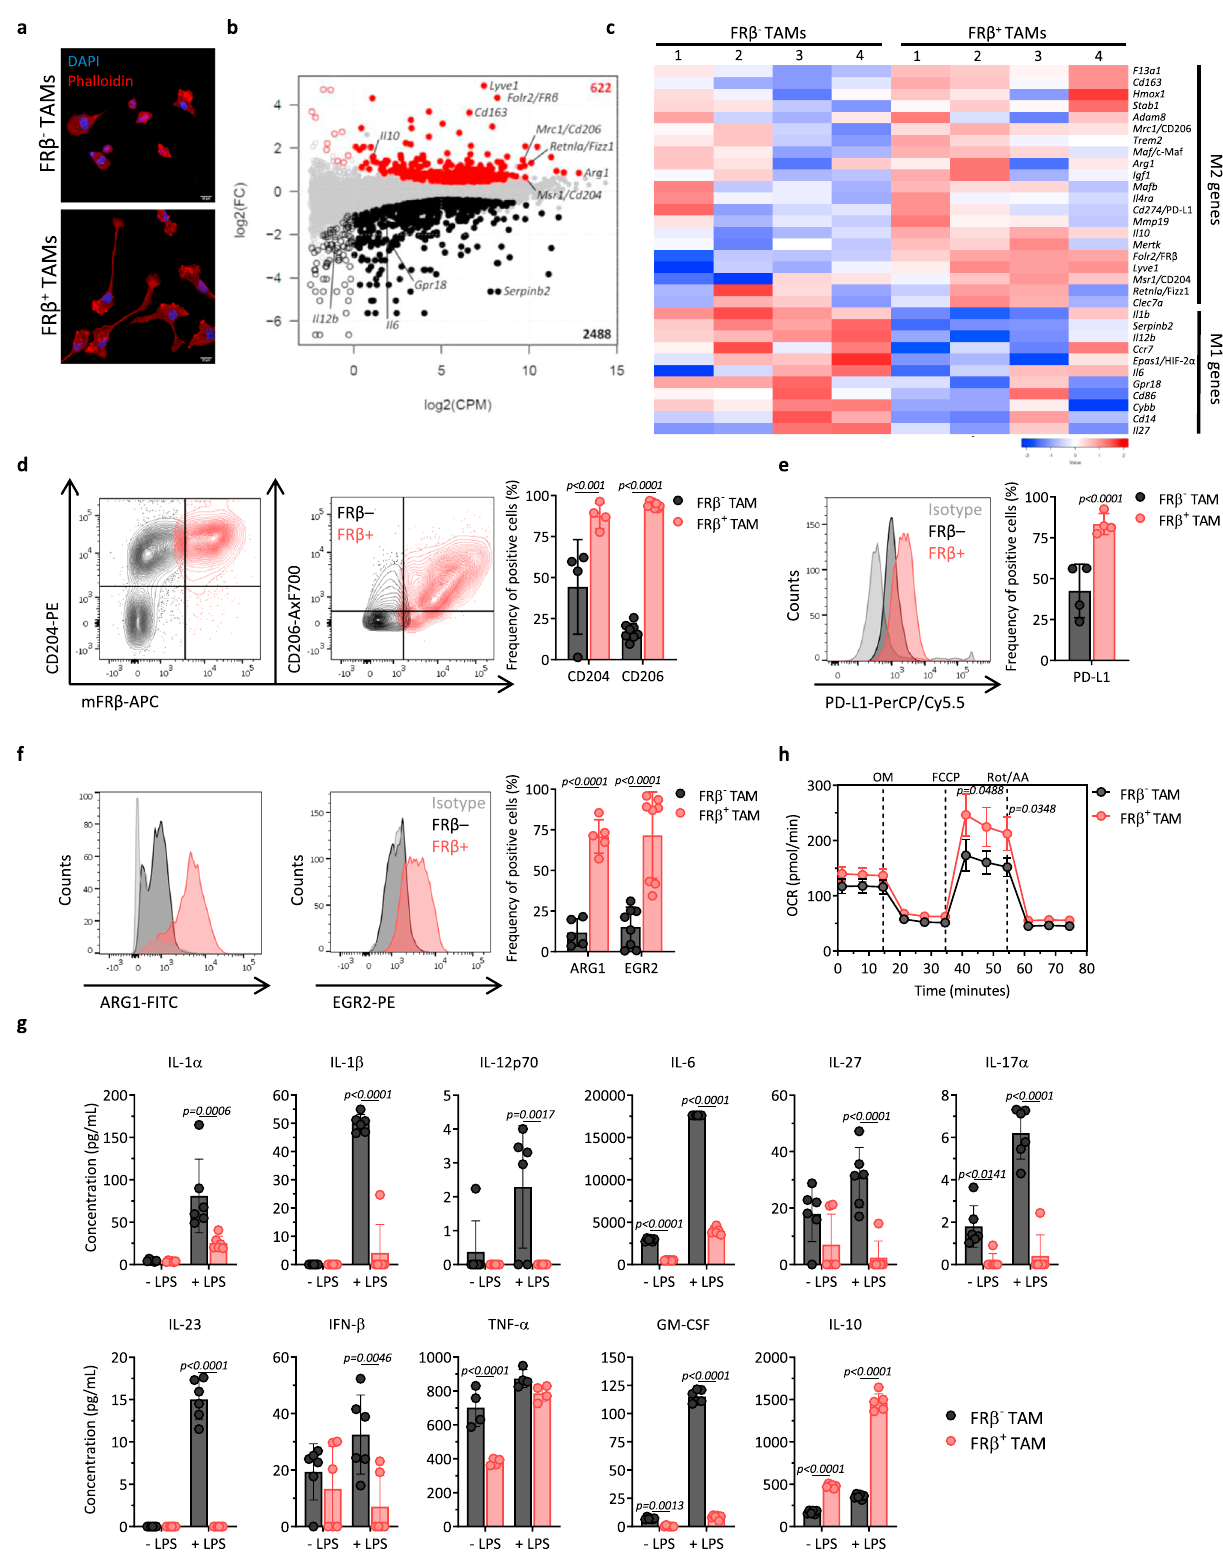
to generate ATP, and M2 macrophages obtaining much of their energy from oxidative phosphorylation 49 . FR β − and FR β + TAMs were harvested and directly sorted to characterize their metabolic activity using a standard Seahorse assay. Oxygen consumption rates (OCRs) were similar in FR β − and FR β + TAMs at